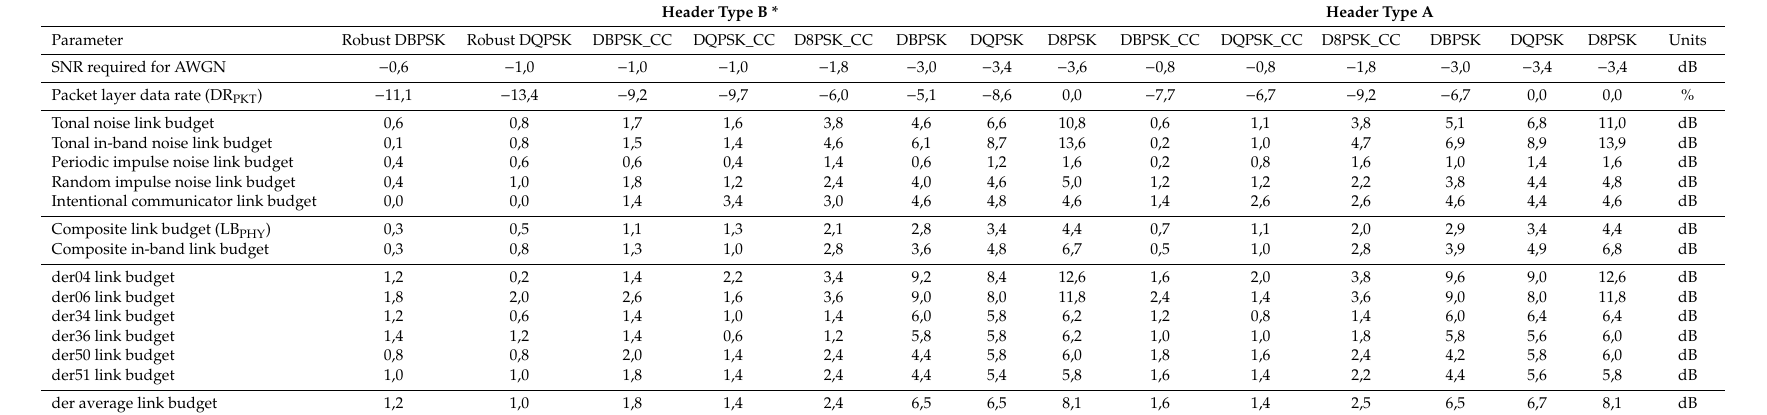
Table 7. Incremental results with Reed–Solomon encoding for PRIME 1.3.6 and 1.4 compared to Table